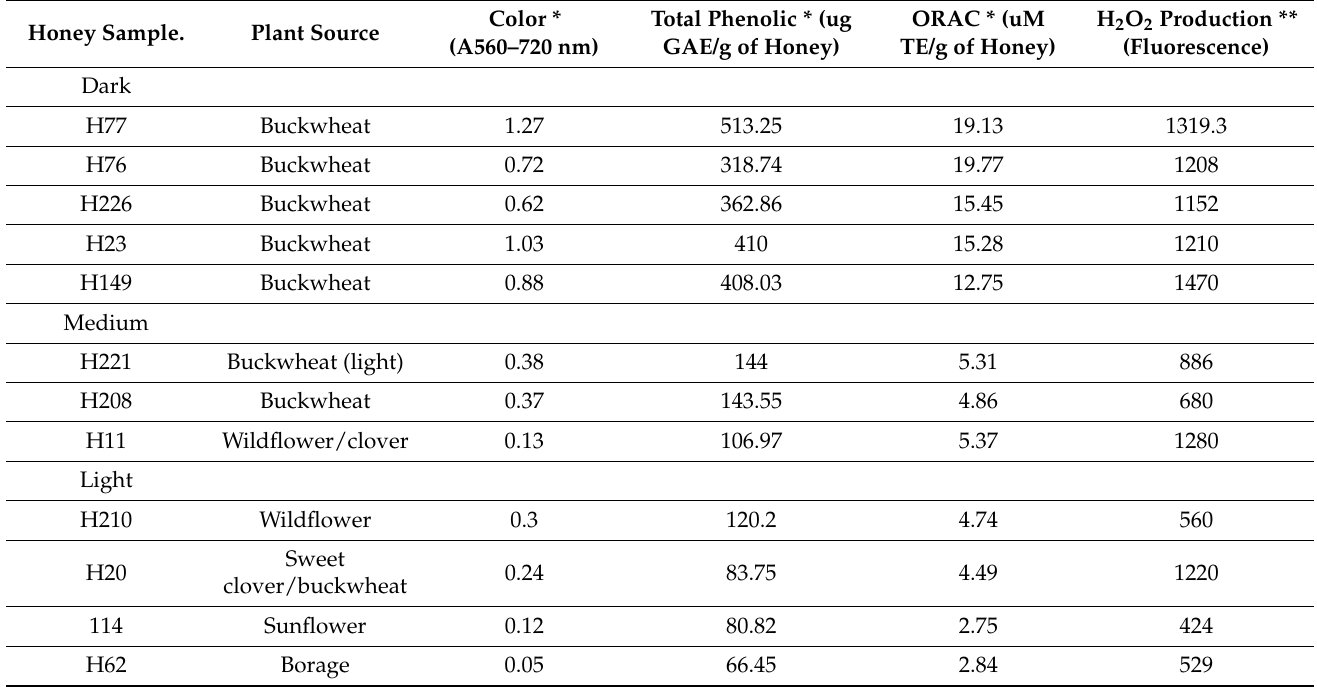
Figure 1. The content of H 2 O 2 produced in dark-, medium- and light- color in honeys (columns). The non-linear relationship between the production of H 2 O 2 and honey dilution is presented as the inverted U- shaped curve (dotted lines). Table 1. List of honeys used and their characteristics.